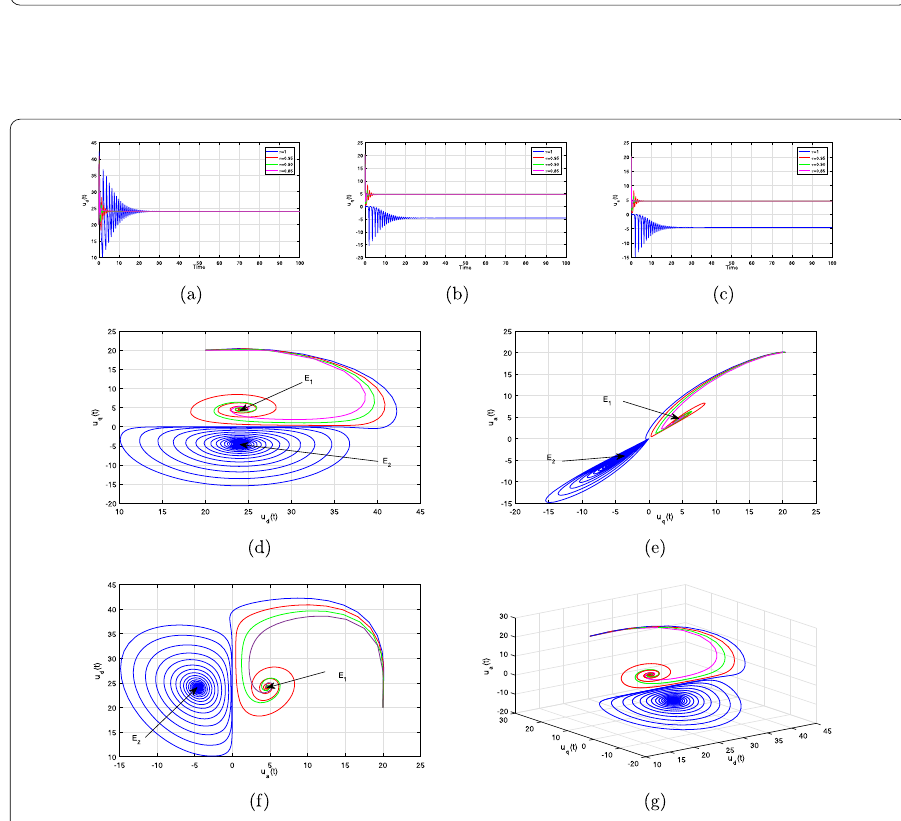
Figure 7 Simulations of Example 6 for time-fractional brushless DC motor (11) in the AB–Caputo